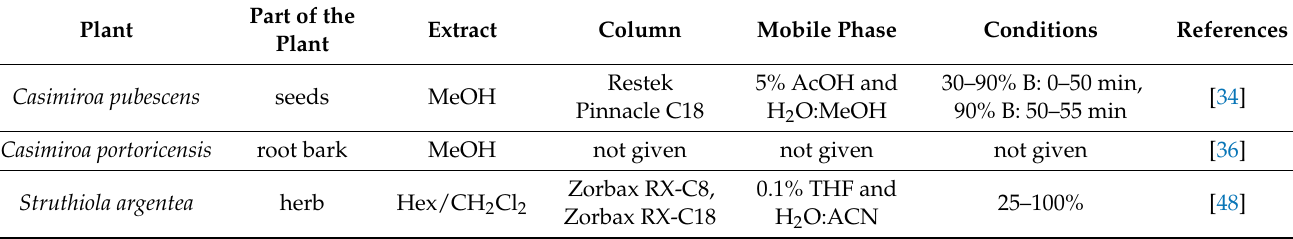
Table 3. High-performance liquid chromatography in the separation of